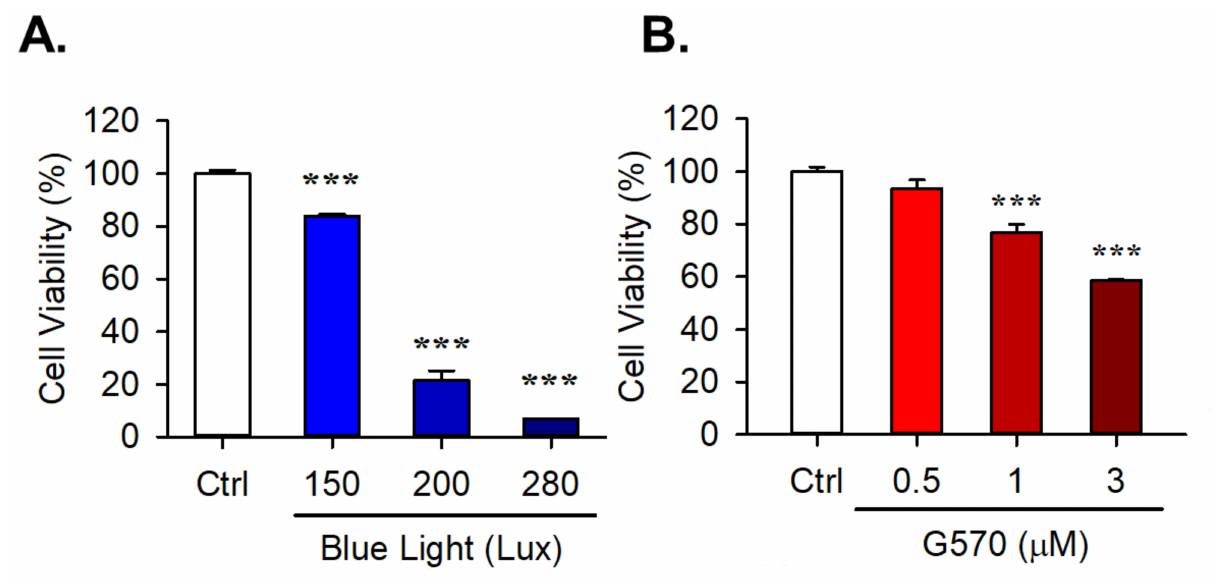
Figure 2. Cell viability of ARPE-19 cells. The cells were seeded in a 48-well plate. The next day, they were treated with varying intensities of BL ( A ) and concentrations of G570 ( B ). After 24 h, the MTT assay was performed to determine cell viability. Data are expressed as the mean ± S.D. and were obtained in triplicates. Significance was estimated compared to the control, where *** ≤